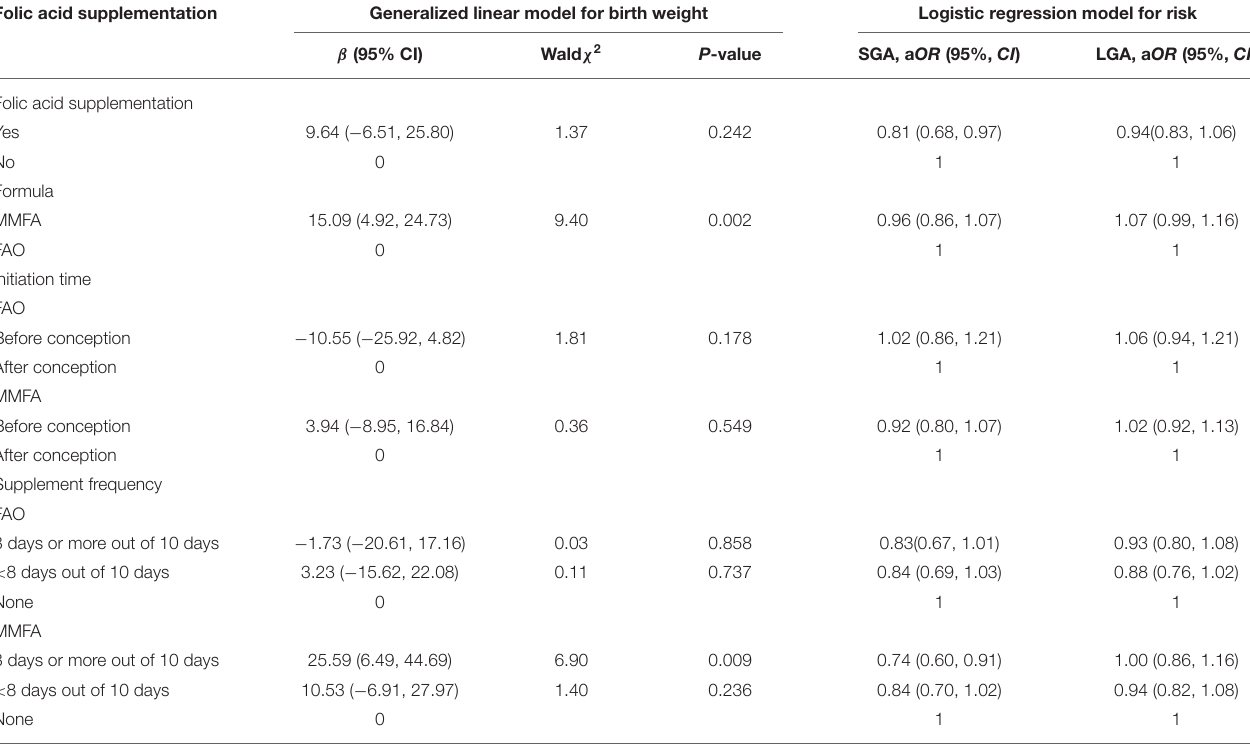
TABLE 5 | Association of periconceptional of folic acid supplementation and birth weight of newborns as well as risk of SGA and LGA evaluated with multivariate models. Folic acid